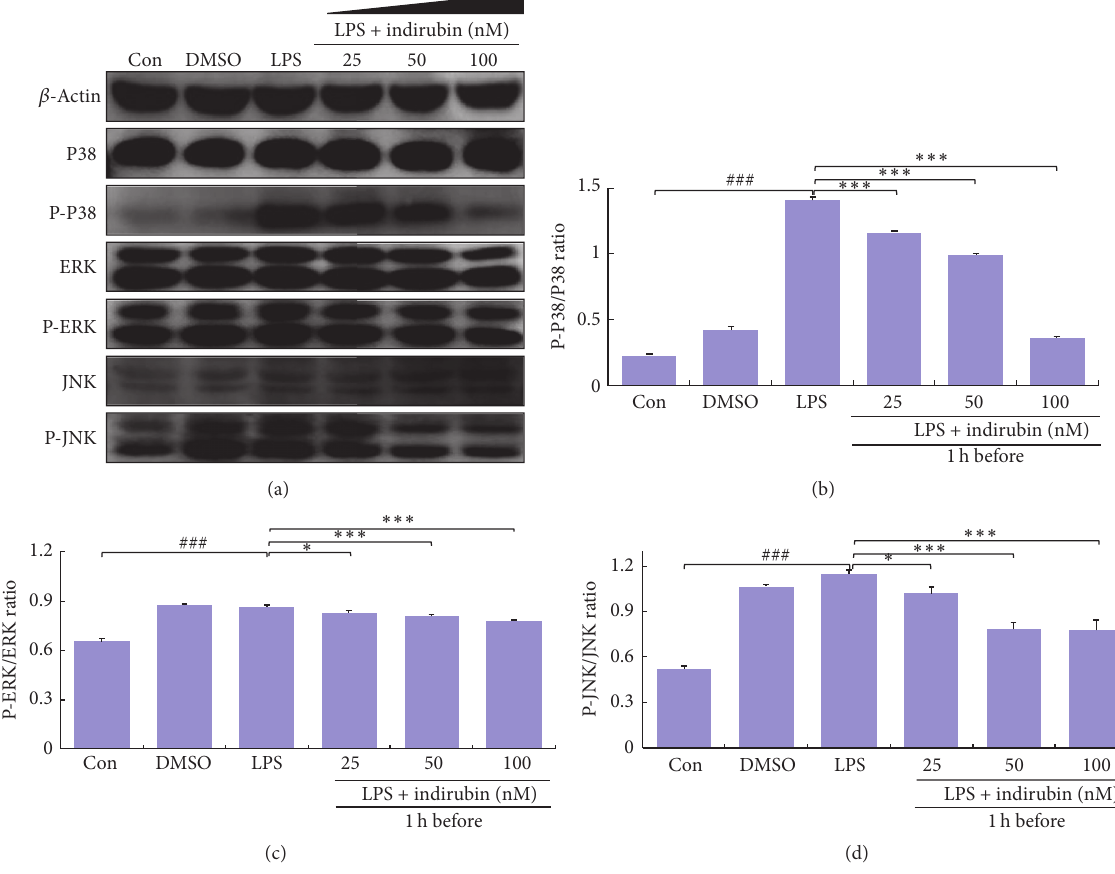
Figure 7: Effects of indirubin on MAPKs expression in LPS-induced MMECs. (a) Cells proteins MAPKs were analyzed by western blotting. (b) Densitometry analysis results of P-P38/P38 expression. (c) Densitometry analysis results of P-ERK/ERK expression. (d) Densitometry analysis results of P-JNK/JNK expression. The cellular proteins were analyzed by western blot and 𝛽 -actin served as internal control. The values are presented as means ± SEM ( 𝑛 = 3 ). ### 𝑝 < 0.001 versus control group; ∗ 𝑝 < 0.05 and ∗∗∗ 𝑝 < 0.001 versus LPS